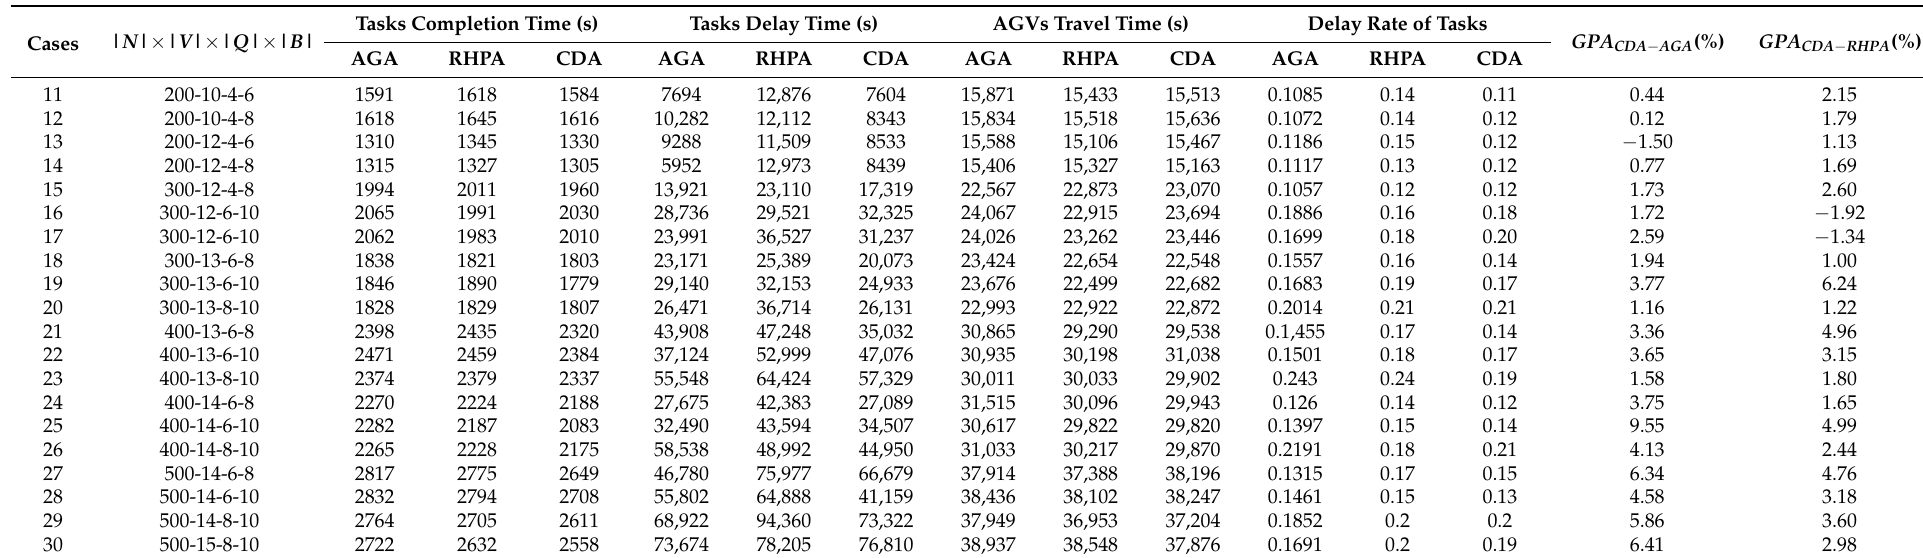
Table A5. Scheduling results of different algorithms with different